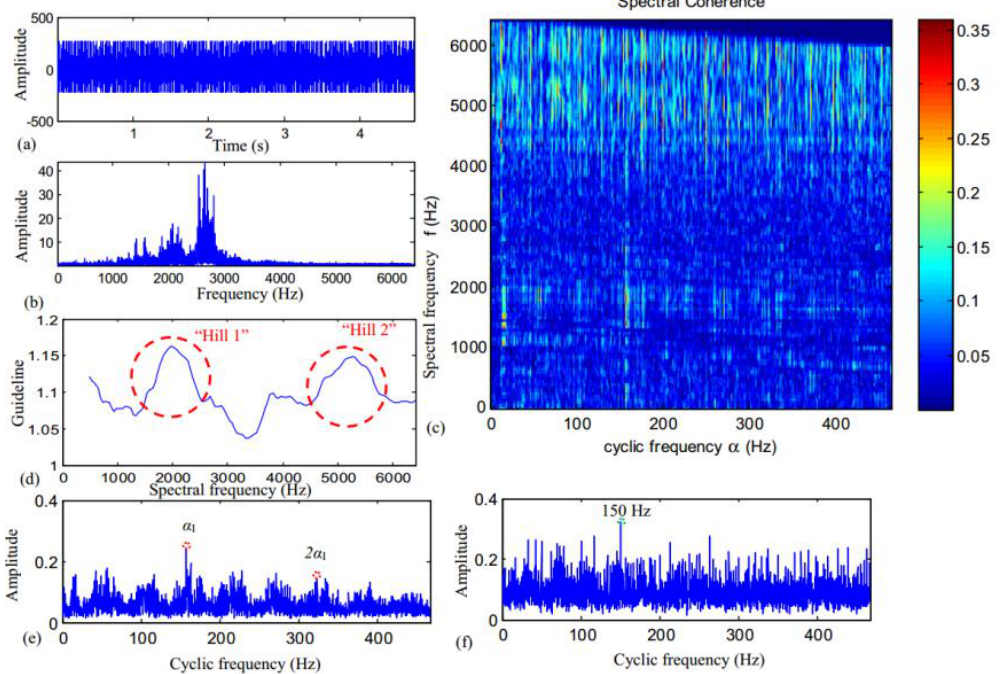
Figure 4. Results obtained by using the proposed method for processing an industrial inner race fault signal: ( a ) A raw inner race fault signal; ( b ) frequency spectrum of (a); ( c ) spectral coherence of the inner race fault signal; ( d ) the proposed guideline; ( e ) EES obtained by integrating spectral coherence over a spectral frequency band from 1564 to 2030 Hz; ( f ) EES obtained by integrating spectral coherence over a spectral frequency band from 4793 to 5259 Hz. EES represents an enhanced envelope spectrum.